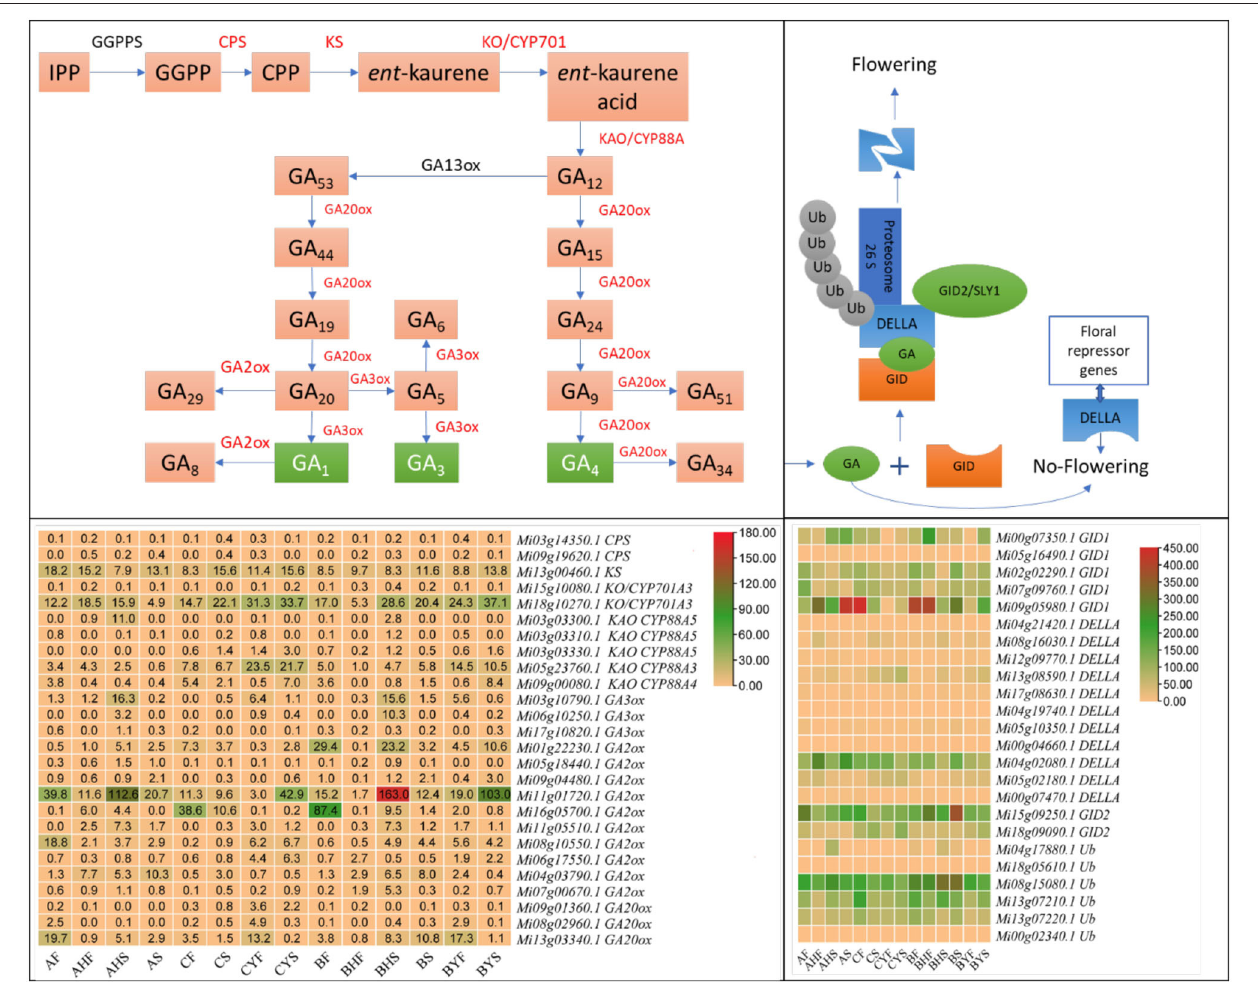
FIGURE 4 | Gibberellin biosynthesis and signaling pathway in mango. The above panels show the key steps in GA biosynthesis and signaling. The respective heatmaps below the pathways show the FPKM values of related genes. Red genes were differentially expressed in GA biosynthesis. IPP, iso pentenyl diphosphate; GGPP, trans -geranylgeranyl diphosphate; CPP, ent -copalyl diphosphate; GGPPS, geranylgeranyl diphosphate synthase; CPS, ent -copalyl diphosphate synthase; KS, ent-kaurene synthase; KO, ent -kaurene oxidase; KAO, ent -kaurenoic acid oxidase; GA, gibberellic acid; ox, oxidase; GID, gibberellin receptor GID; DELLA, GRAS family protein; Ub, ubiquitin ligase. The blue broken box represents degraded DELLA